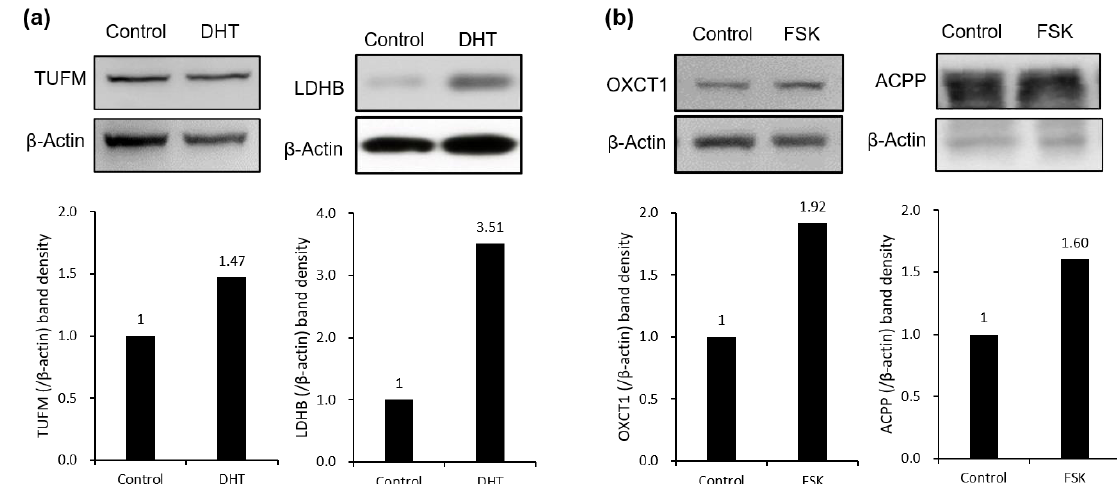
Figure 4. Confirmation of significant changes in the protein expression level. The levels of proteins found to be significantly regulated by DHT ( a ) and FSK ( b ) in our 2DE analysis were confirmed by western blot analysis. Results are the representative of three independent experiments and fold change of expression was labeled.